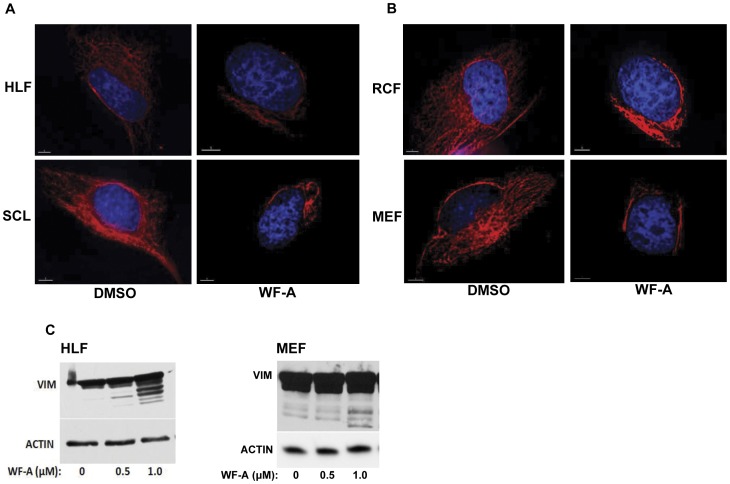
Effect of WF-A on integrity of vimentin filaments in fibroblasts.A. Disruption of vimentin filaments in human fibroblasts treated with WF-A. Primary human lung fibroblasts (HLF, upper panels) and scleroderma fibroblasts (SCL, lower panels) were treated for 2 h with DMSO or with 1.0 µM of WF-A and immunostained with anti-vimentin antibody. Nuclear staining was by DAPI (blue). Bars, 1 µm. B. Collapse of vimentin filaments in rodent fibroblasts treated with WF-A. Experiment as in A, except primary rat cardiac fibroblasts (RCF, upper panels) and mouse embryonic fibroblasts (MEF, lower panels) were treated with DMSO or 1.0 µM of WF-A. Bars, 1 µm. C. Degradation of soluble vimentin by WF-A. Soluble vimentin was extracted with high salt buffer from HLF (left) and MEF (right) after treatment with the indicated concentrations of WF-A for 2 h. Vimentin (VIM) was analyzed by Western blot. Loading control: actin.